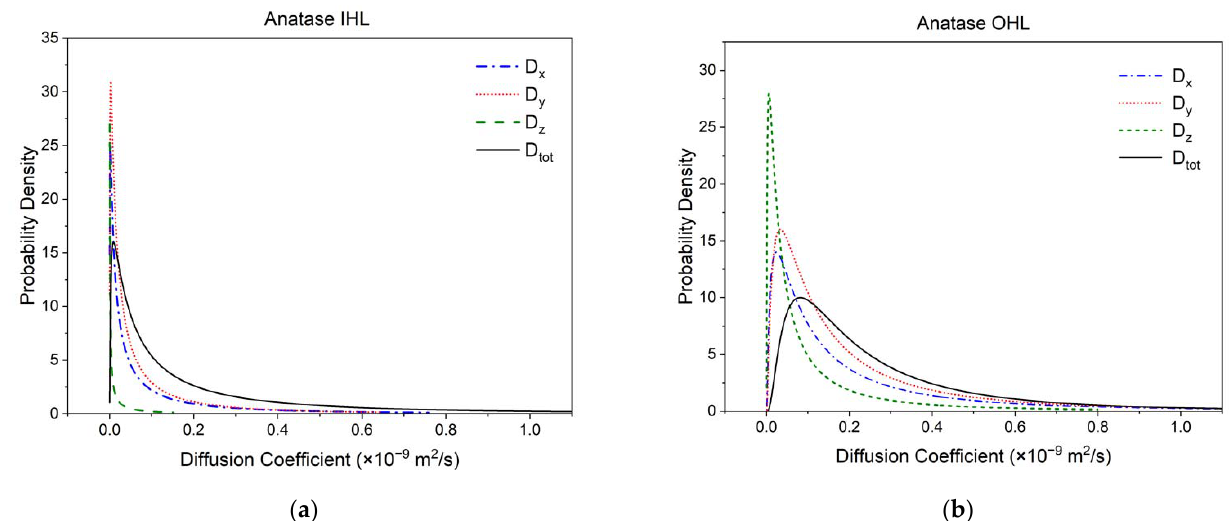
Figure 4. Probability distribution of self ‐ diffusion coefficients of each individual water molecule averaged over a 300 ps sub ‐ interval for anatase (101) ( a ) IHL ( b ) OHL. Note that these molecules are distinct from the average with 95% confidence. Diffusivities of the x, y, z directions are shown in blue, red and green dashed lines, respectively. The total diffusivity of individual molecules is represented by the solid black